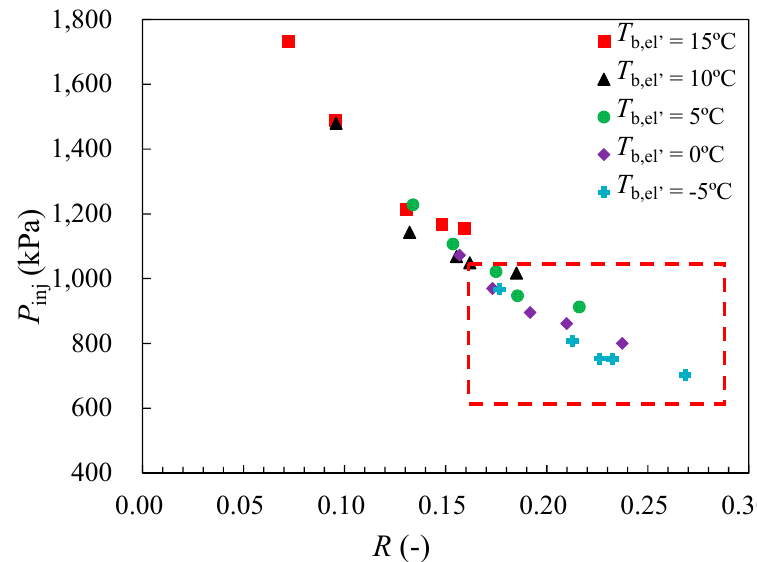
Figure 18. The injection pressure P inj with the change of injection ratio R in the vapor injection heat pump cycle.